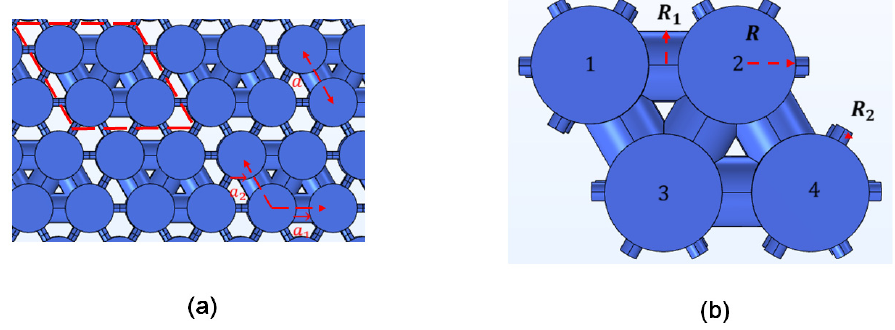
Figure 1. ( a ) Schematic diagram of periodic triangular-lattice structure; ( b ) Unit cell.